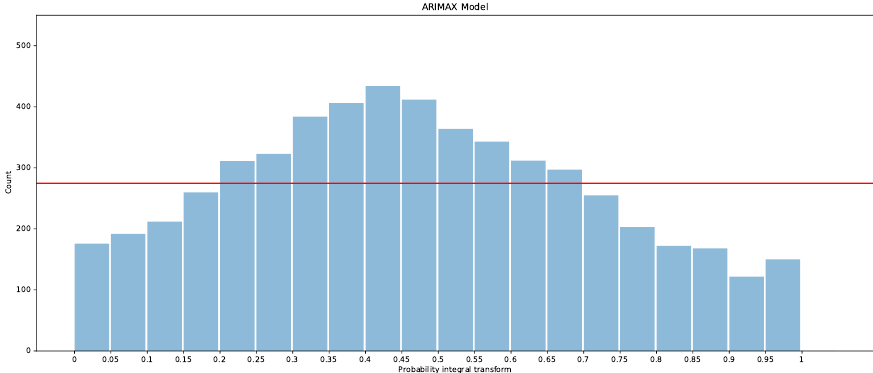
Figure A7. PIT for the ARIMAX model for the entire test